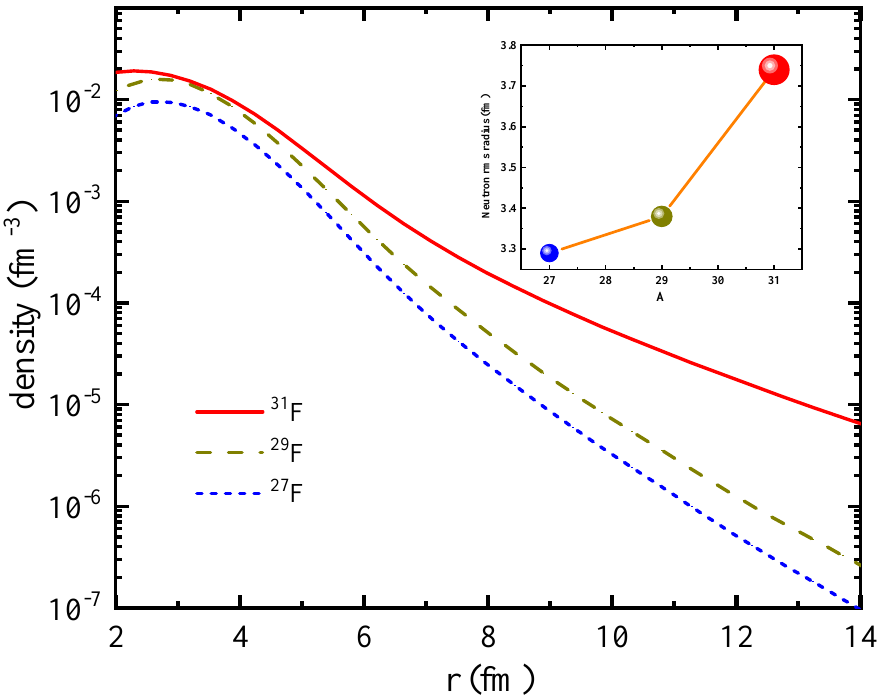
Figure 7. One-nucleon densities of the bound 27,29,31 F isotopes calculated with the GSM using the EFT interaction in the valence space as a function of radii r , respectively, depicted by short-dashed, long-dashed, and solid lines. The rms radii of these isotopes are shown in the inset (with permissions from Ref.